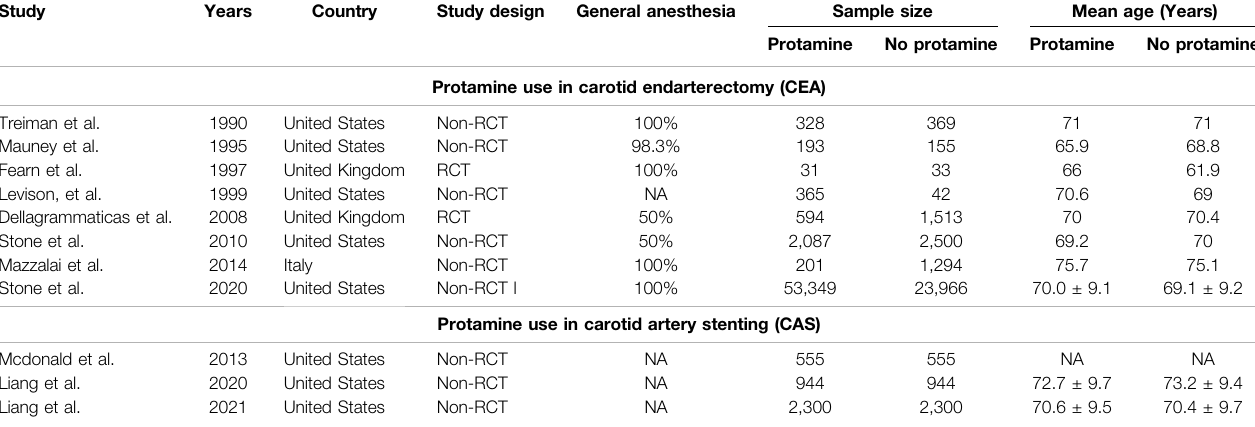
TABLE 2 | Characteristics of publication year, country, study type, cases, general anesthesia, and mean age in each group for included studies.